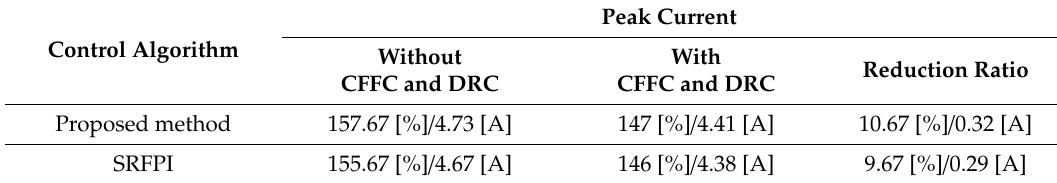
Table 4. Simulation results of GCI system phase current without and with the CFFC and DRC.